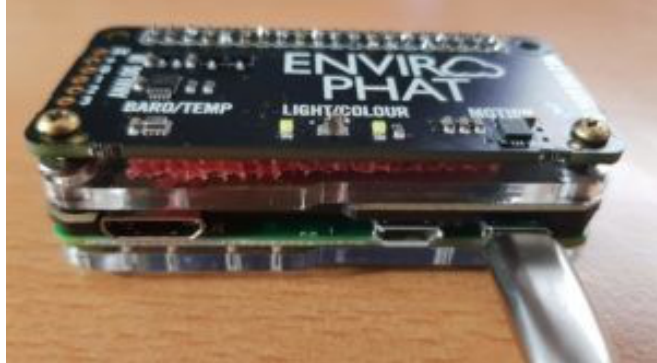
Figure 2. One of the Raspberry Pi Zero boards used in the